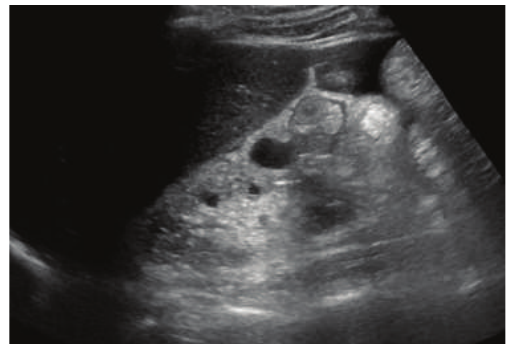
Figure 4: Renal US long R kidney demonstrating atrophy and cysts.